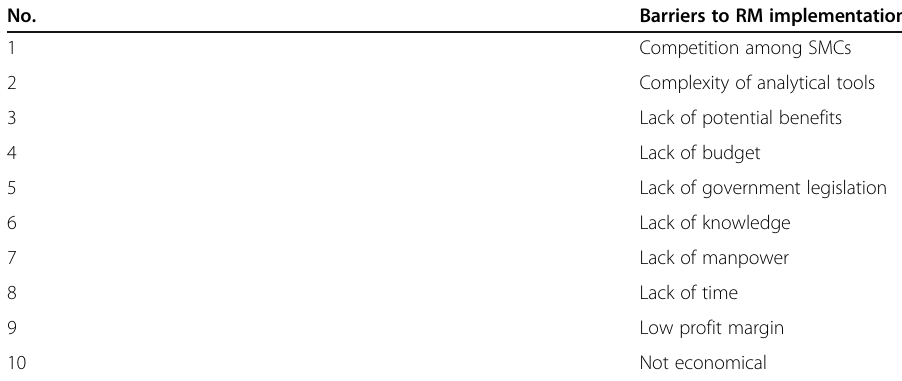
Table 8 Barriers to RM implementation in in small projects